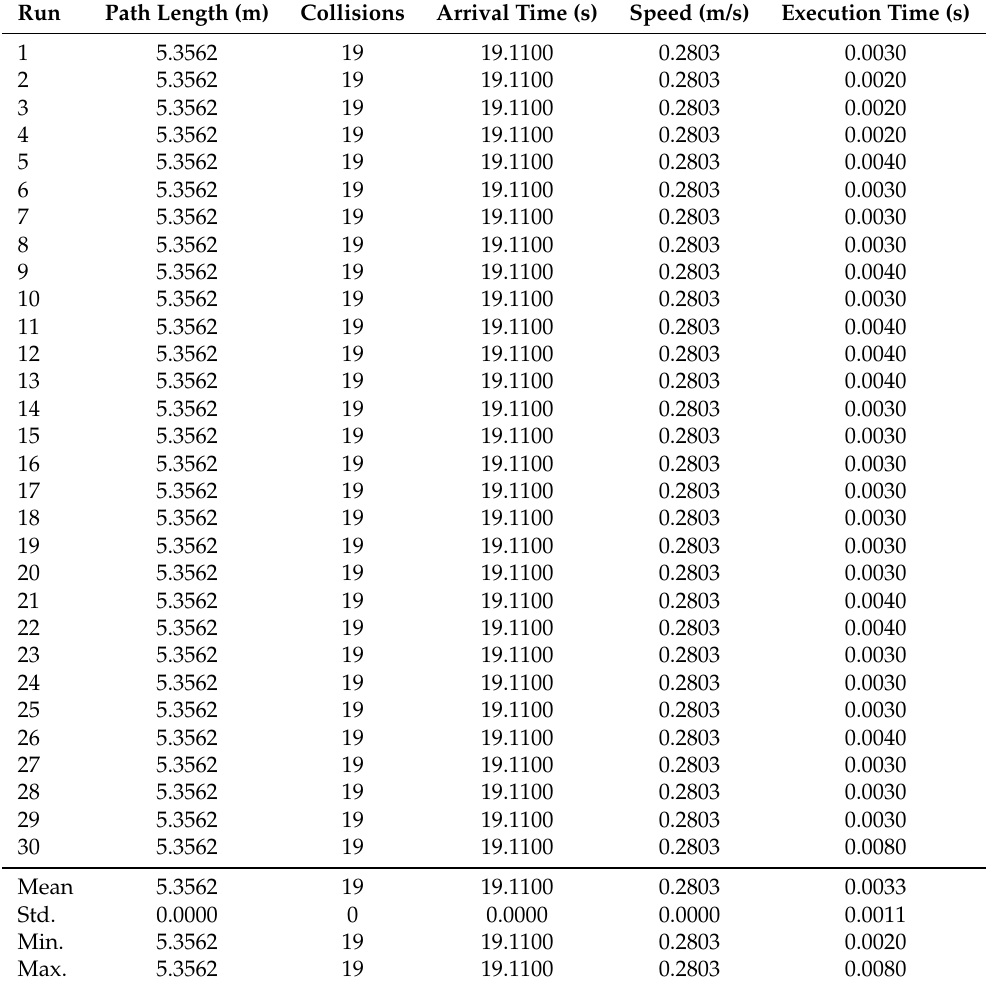
Table 6. Results of Bug0 − after 30 independent